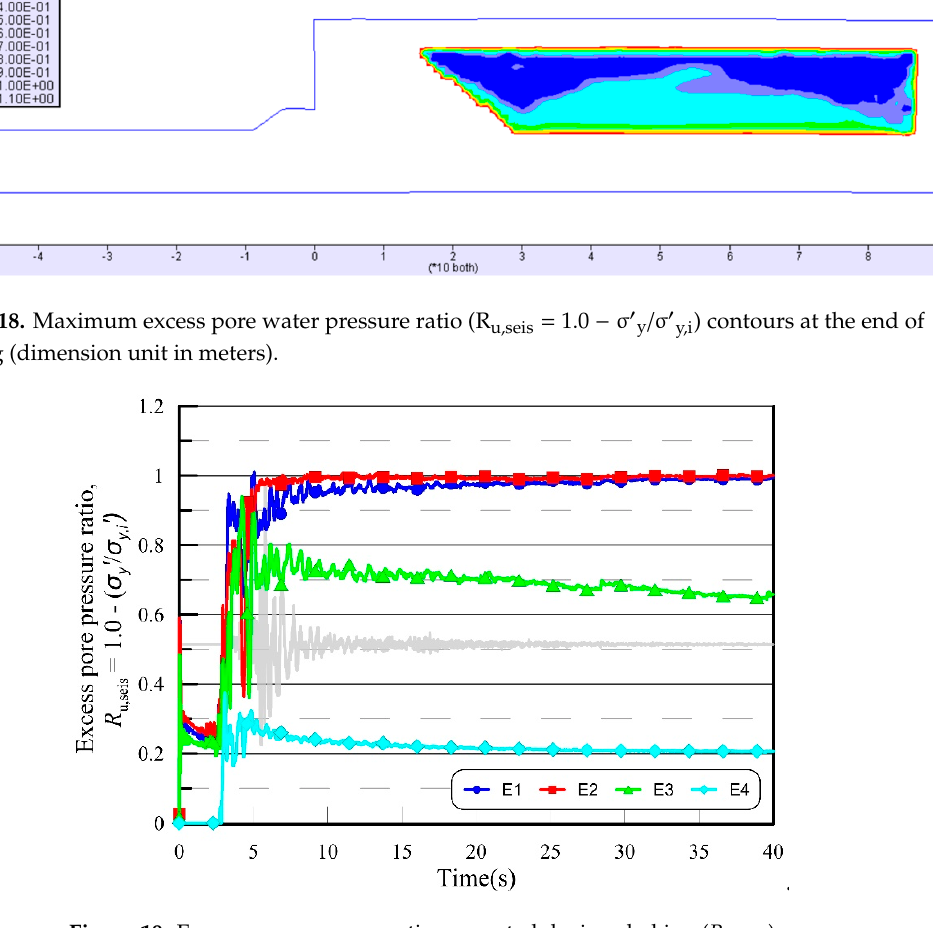
Figure 20. Displacement at the end of shaking (dimension unit in meters).